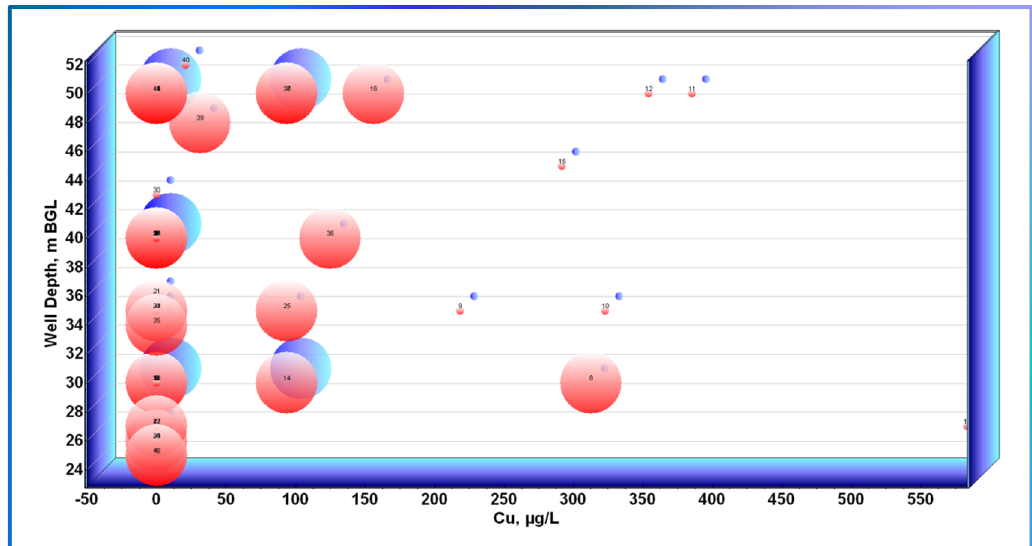
Figure 9. Bubble plot of the well depth and Cu concentrations combined interaction on TC ( blue ) and E. coli ( red ).